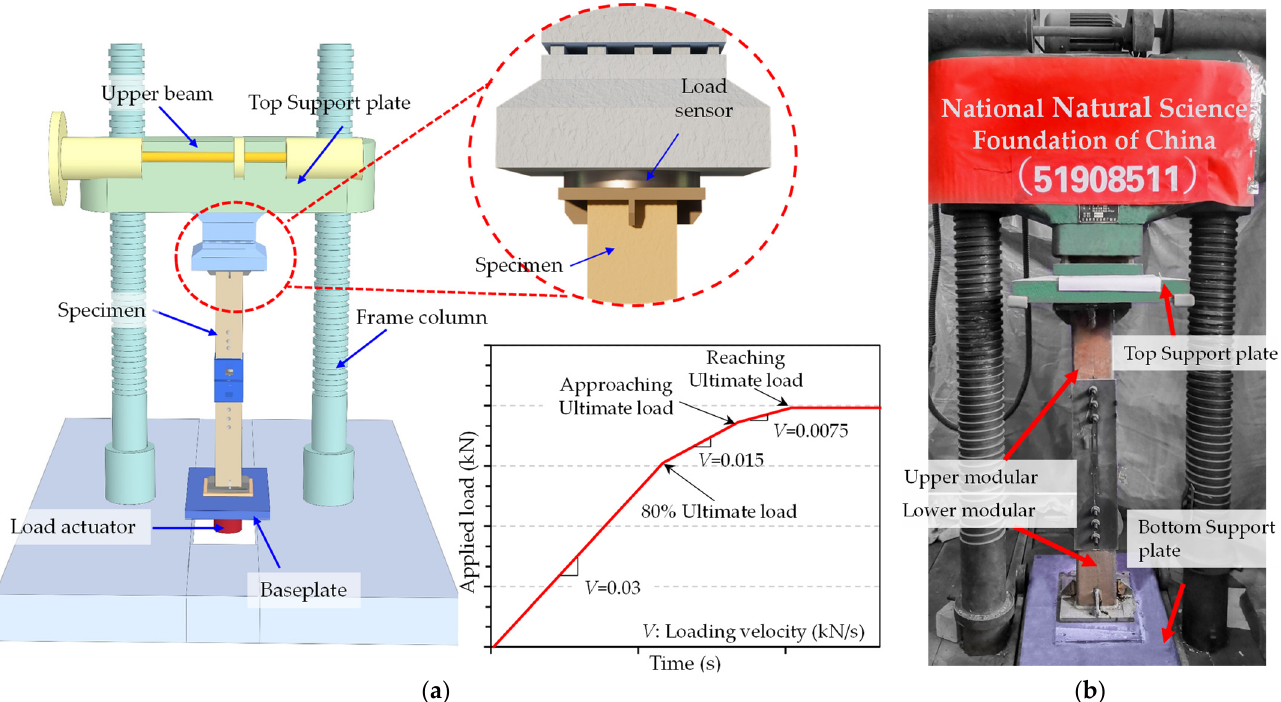
Figure 8. Test schematic of the FPLC under axial load: ( a ) schematic diagram; ( b ) on-site